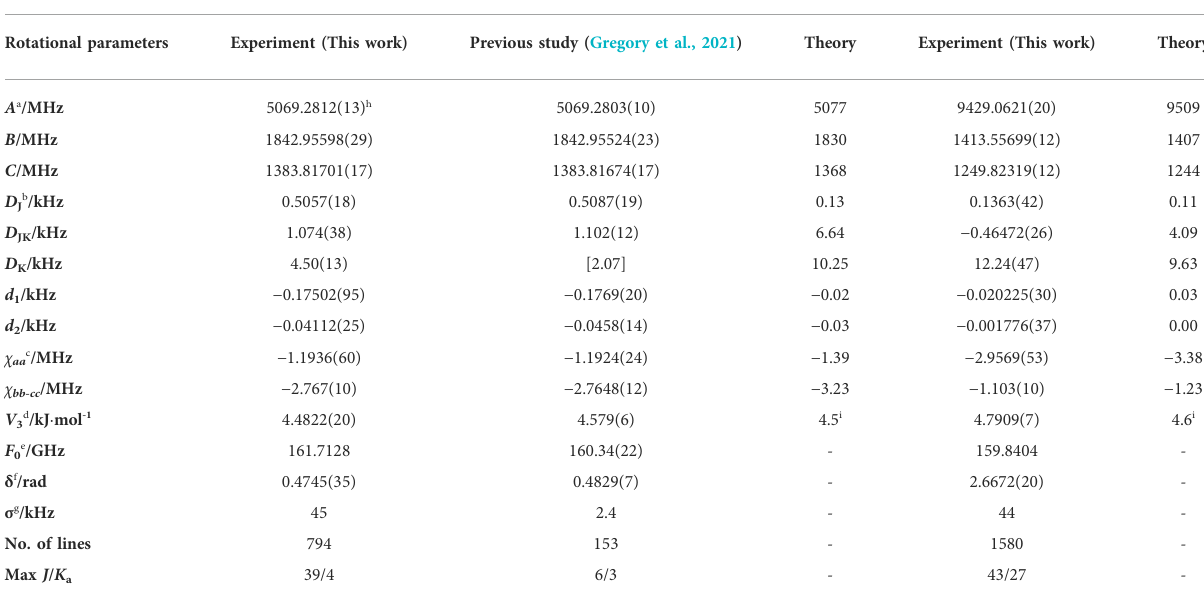
TABLE 2 Experimental and theoretical rotational parameters for the two observed conformers of MCA. The theoretical rotational parameters were obtained at the B3LYP-D3/aug-cc-pVTZ level of theory. MCA_1 MCA_2 Rotational parameters Experiment (This